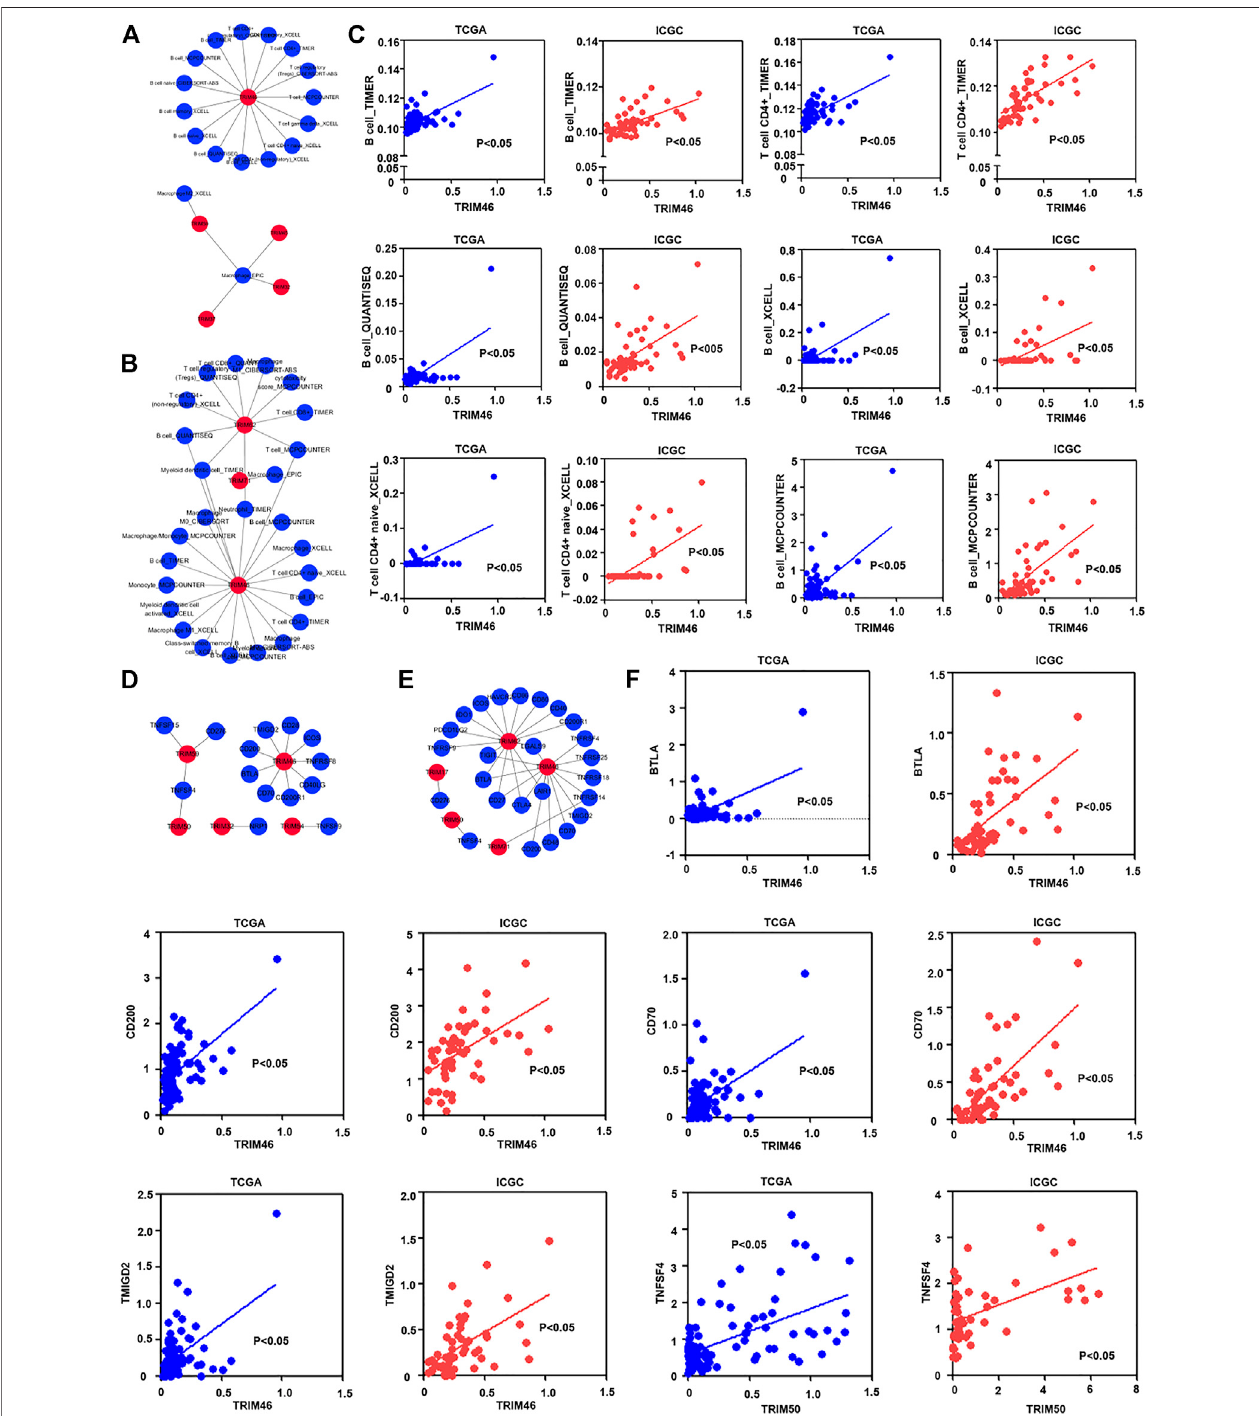
FIGURE 4 | The correlation of TRIM genes with immune cells and immune checkpoint genes in HBV-positive HCC. (A) . The co-expression pattern of TRIMs with immunecellsinHBV-positiveHCCinTCGAcohort. (B) Theco-expressionpatternofTRIMswithimmunecellsinHBV-relatedHCCinICGCcohort. (C) Thecommonco- expressionpatternofTRIMgeneswithimmunecellsinHBV-positiveHCCinbothtwocohorts. (D) Theco-expressionpatternofTRIMswithimmunecheckpointgenesin HBV-associated HCC in TCGA cohort. (E) The co-expression pattern of TRIM genes with immune checkpoint genes in HBV-positive HCC in the ICGC cohort. (F) The common co-expression pattern of TRIM genes with immune checkpoint genes in HBV-associated HCC in TCGA and ICGC cohorts.